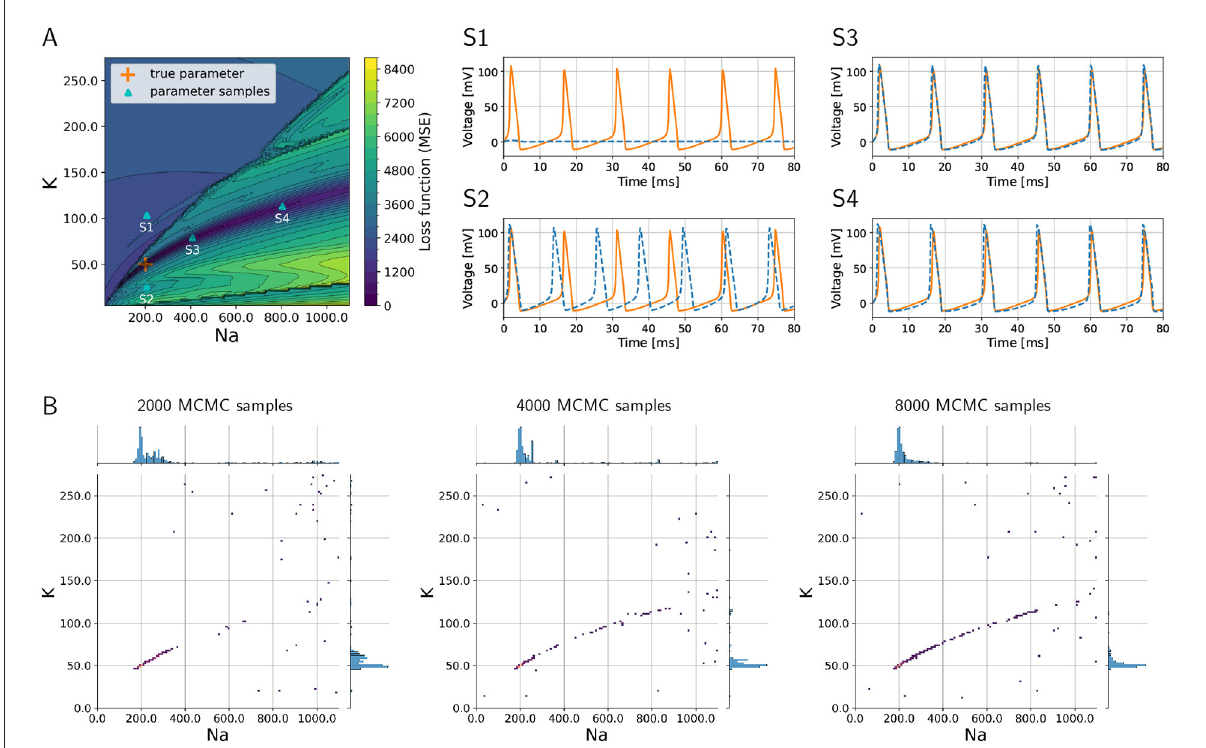
FIGURE2 Loss function corresponding to the inverse problem with a three-channel HH model and how MCMC is able to successfully recover multiple optimal parameter sets and quantify uncertainties and parameter trade-offs. (A) Loss function landscape (colors) over the parameters, sodium ( g Na ) and ( g K ) potassium conductances. The “true” parameter set represents a global minimizer of the loss; the valley of the loss along points S3 and S4 (in dark blue color of loss) translates to parameter uncertainties (or trade-offs). Graphs S1–S4 depict voltage traces at corresponding points in (A) . (B) Densities of MCMC samples, where the dark purple color of highest density overlaps with the true parameter set. As the number of MCMC samples increases, the the method recovers the valley of the loss landscape A and hence quantifies uncertainties in the